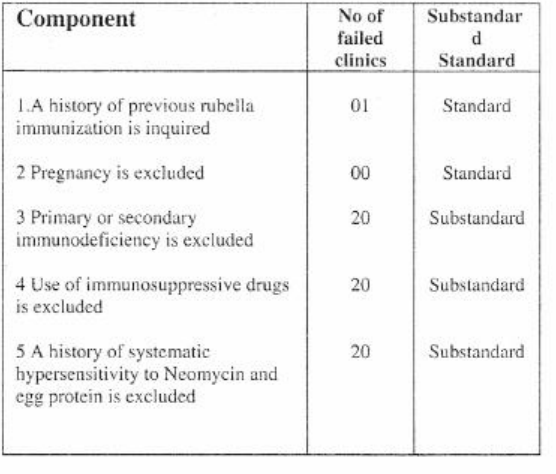
‘Table3. Assessmentof the screening of clients eligible for rubella vaceination (n=20,d=6)